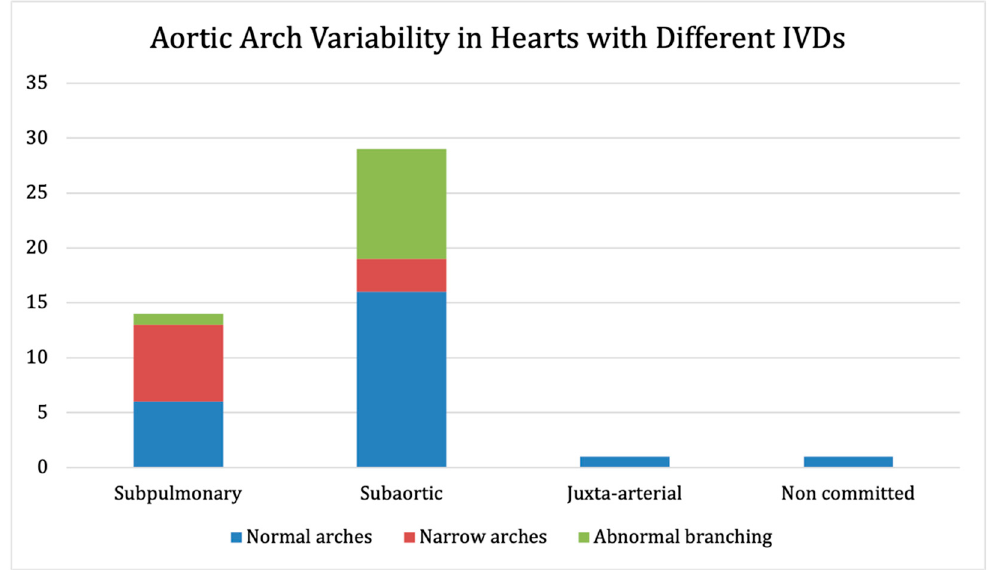
Figure 5. Arch variability in hearts with different interventricular communications.